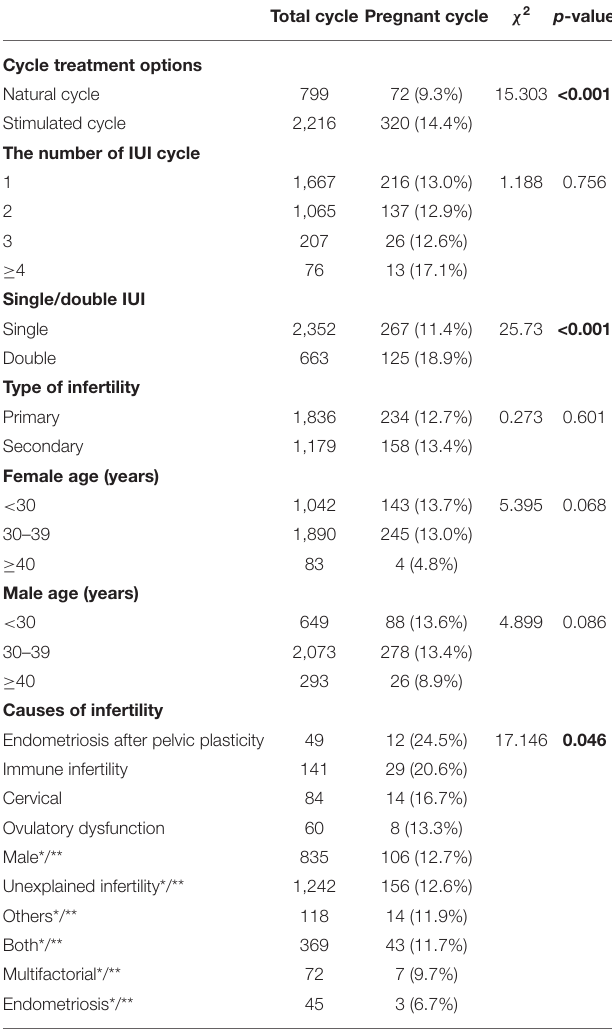
TABLE 1 | Association between clinical characteristics and AIH pregnancy